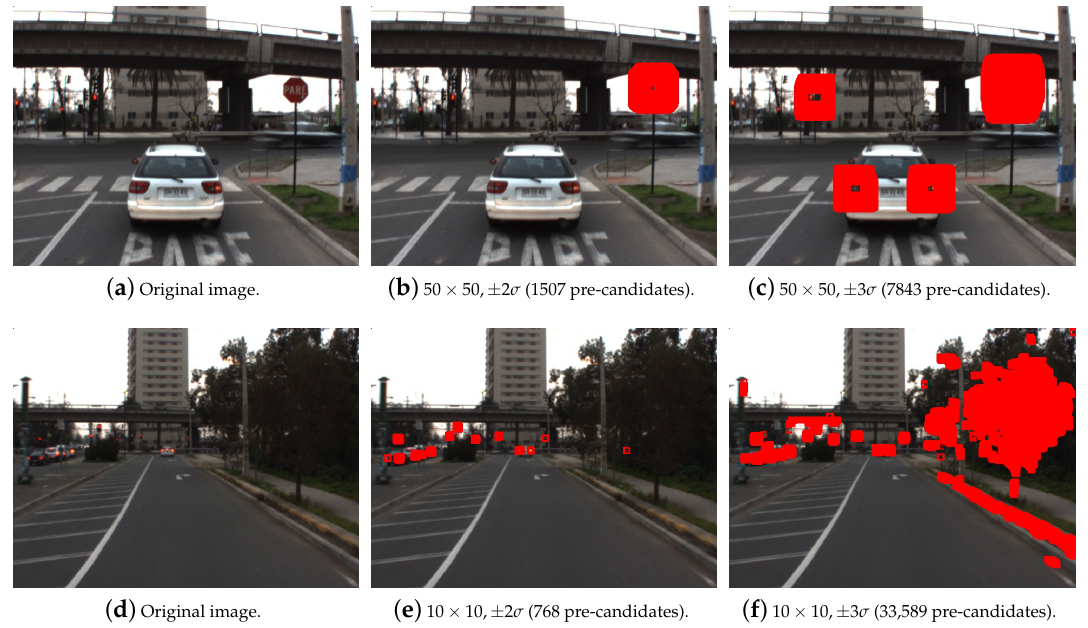
Figure 3. Examples of ROI (regions of interest) candidates generated for the stop sign using the chromaticity filter before region